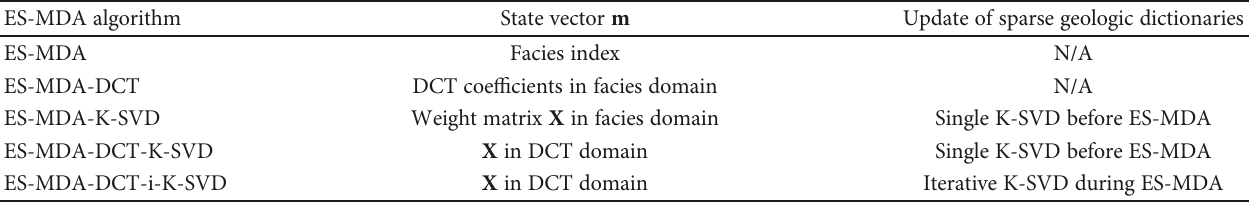
Table 1: State vectors and update processes of sparse geologic dictionaries for fi ve ES-MDA algorithms investigated in this study. ES-MDA algorithm